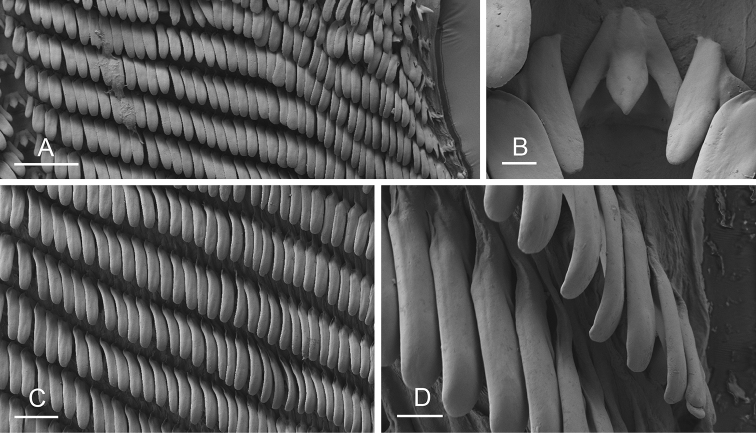
Radula, Peronia
griffithsi, Mauritius A holotype [3157 H] (MNHN-IM-2000-35265) B–D [3153] (MNHN-IM-2019-1608) A right half rows of teeth B rachidian and lateral teeth C lateral teeth D outermost lateral teeth. Scale bars: 100 μm (A), 10 μm (B, D), 60 μm (D).